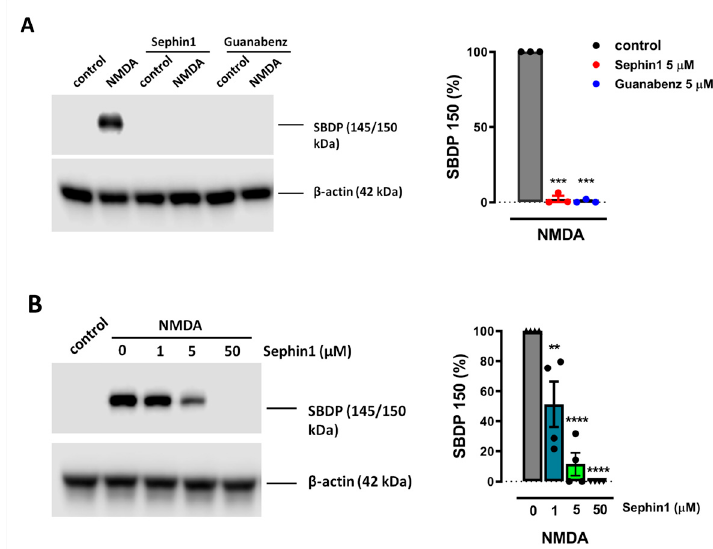
Figure 5. Sephin1 and guanabenz inhibit NMDA-induced calpain activation. ( A ) Neurons were exposed to NMDA (100 µ M, 30 min) in the absence or presence of Sephin1 or guanabenz (5 µ M) and harvested 4 h later for the detection of α II-spectrin breakdown products (SBDP) and β -actin by Western blot. *** p < 0.001 compared with cells treated with NMDA alone (100%), paired Student’s t-test. ( B ) Neurons were treated with NMDA (100 µ M, 30 min) in the absence or presence of increasing concentrations of Sephin1 (1, 5, 50 µ M) and harvested as above. ** p < 0.05, **** p < 0.0001 compared with control (NMDA alone), one-way ANOVA followed by Bonferroni´s post hoc test. In all cases, for the quantification of calpain activity, SBDP150 / 145 signal was measured and normalized to β -actin values.